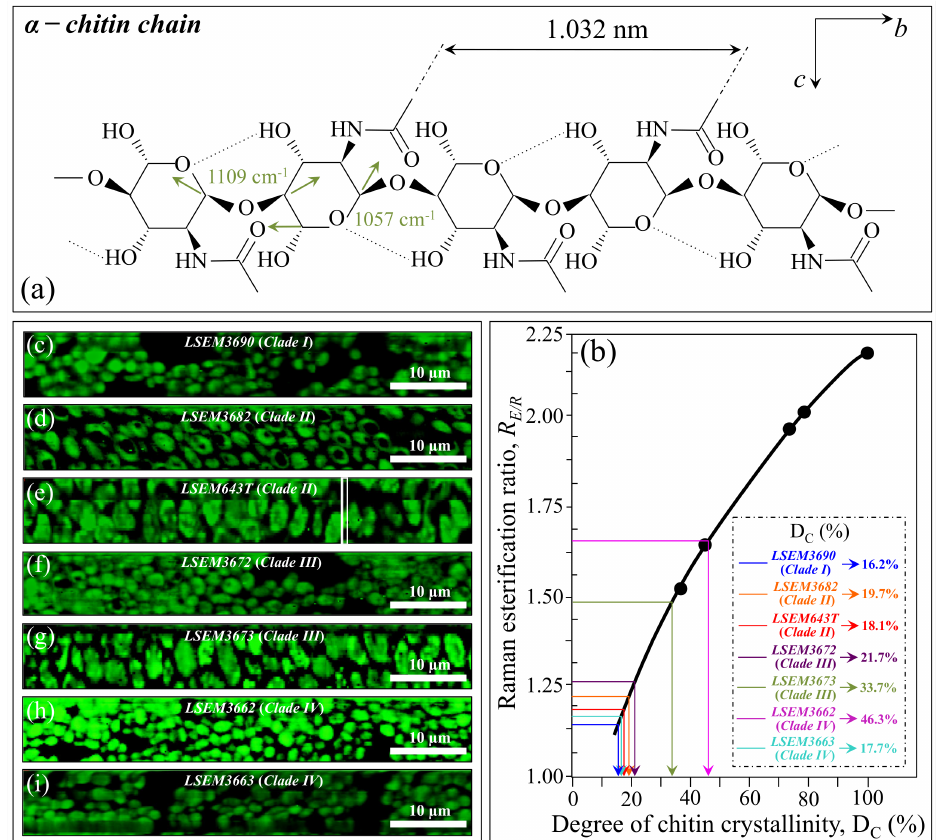
Figure 7. Molecular structure of ( a ) α –chitin (with the respective Raman fingerprint vibrations for inter- and intra-chain C–O–C bonds); ( c ) Raman calibration plot of the R E/R = I 1107 / I 1054 intensity ratio vs. degree of chitin crystallinity, D C (built from data in Ref. [59]); ( c – i ): Raman images of the R E/R ratio collected on different C. auris samples (cf. labels). The average R E/R value for each image locates the respective D C value on the calibration plot ( b ) (cf. values shown in inset given in